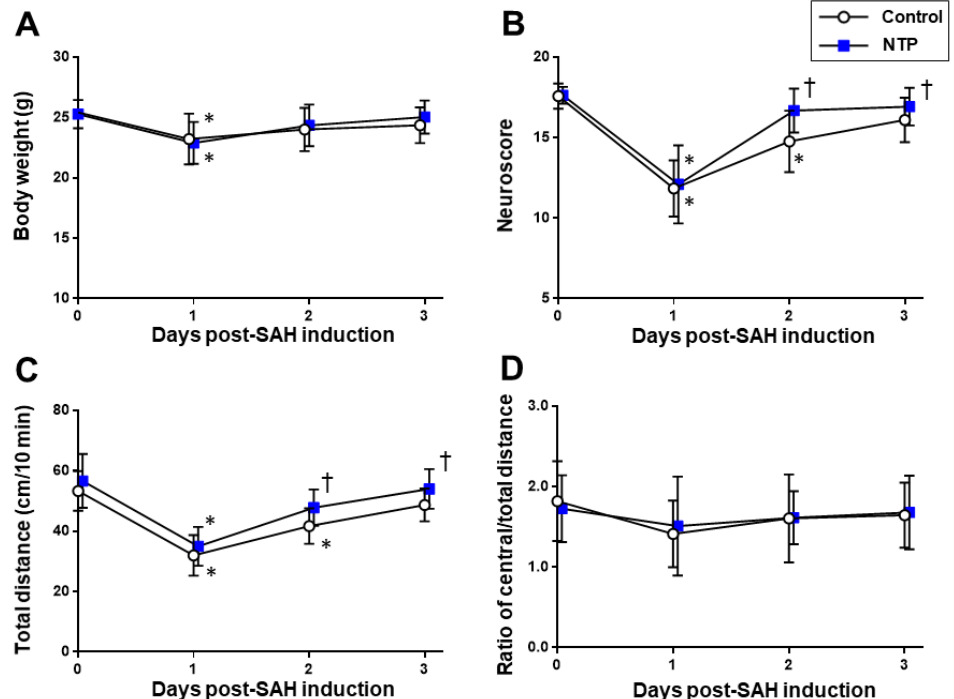
Figure 3. Time–course changes of the cardiorespiratory and cerebrovascular parameters in the acute phase after SAH induction in the control and neurotropin groups. Body weight ( A ). Neuroscore ( B ). Total distance ( C ) and ratio of the central/total distance ( D ) obtained in the open-field test. * p < 0.05 vs. baseline; † p < 0.05 vs. control; two-way ANOVA with a post hoc analysis (Bonferroni–Dunn’s test). NTP, neurotropin.